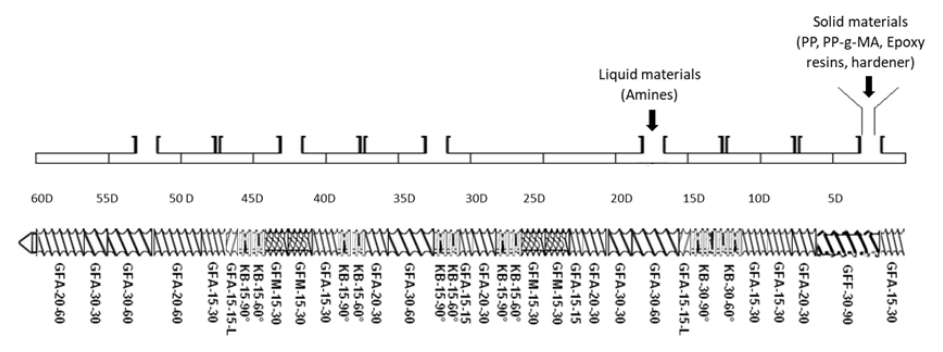
Figure 1. Diagram of the screw profile in the study.